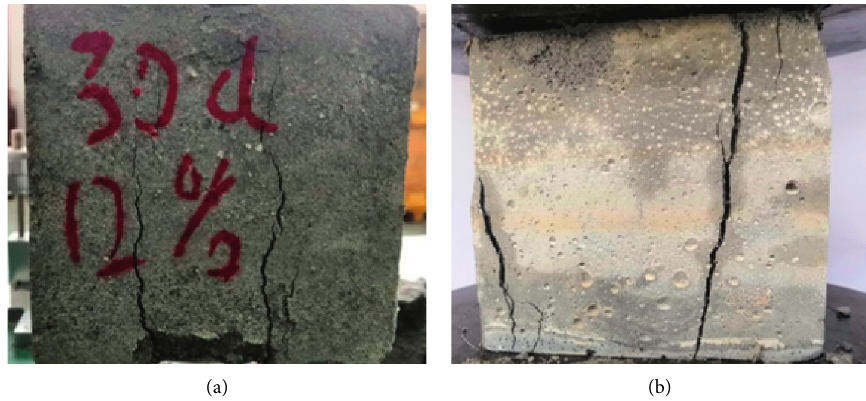
Figure 3: The failure patterns of UCS test